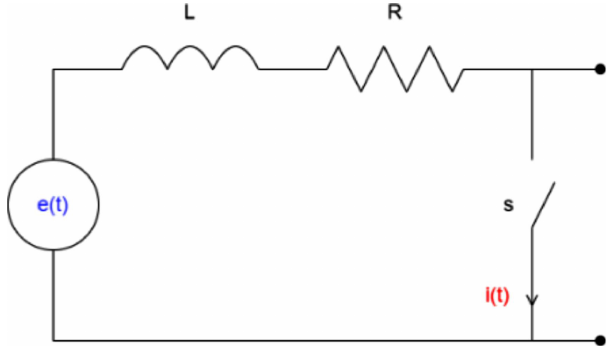
Fig. 7. Simple RL circuit with a switch to short-circuit.